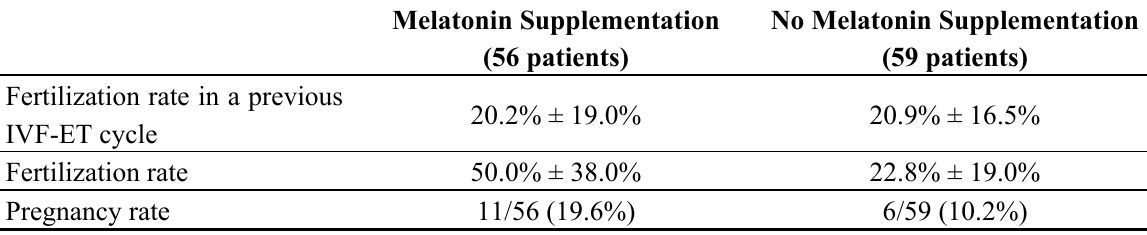
Table 1. Melatonin, 3 mg daily, improved the clinical outcome of patients undergoing IVF-ET ( in vitro fertilization + embryo transfer). One hundred and fifteen women (56 + 59) who had failed to become pregnant in a previous IVF-ET cycle were either supplemented with melatonin or not given the